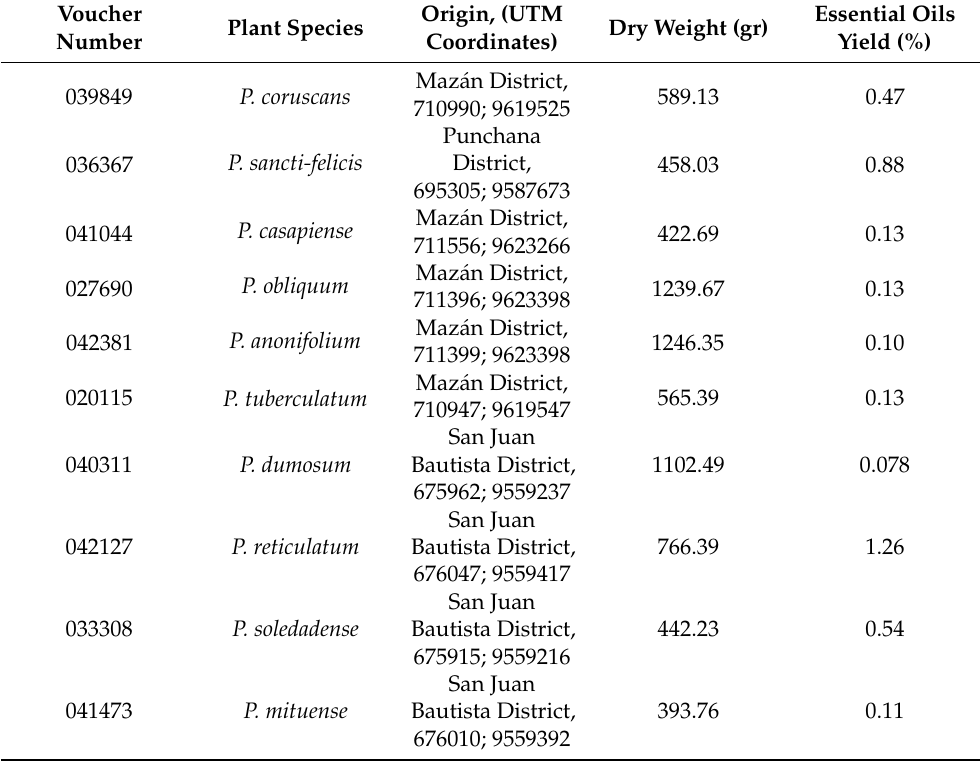
Table 4. List of the plant species used and their origin (experimental field locations in Iquitos, Peru, and UTM coordinates), dry weight and essential oils